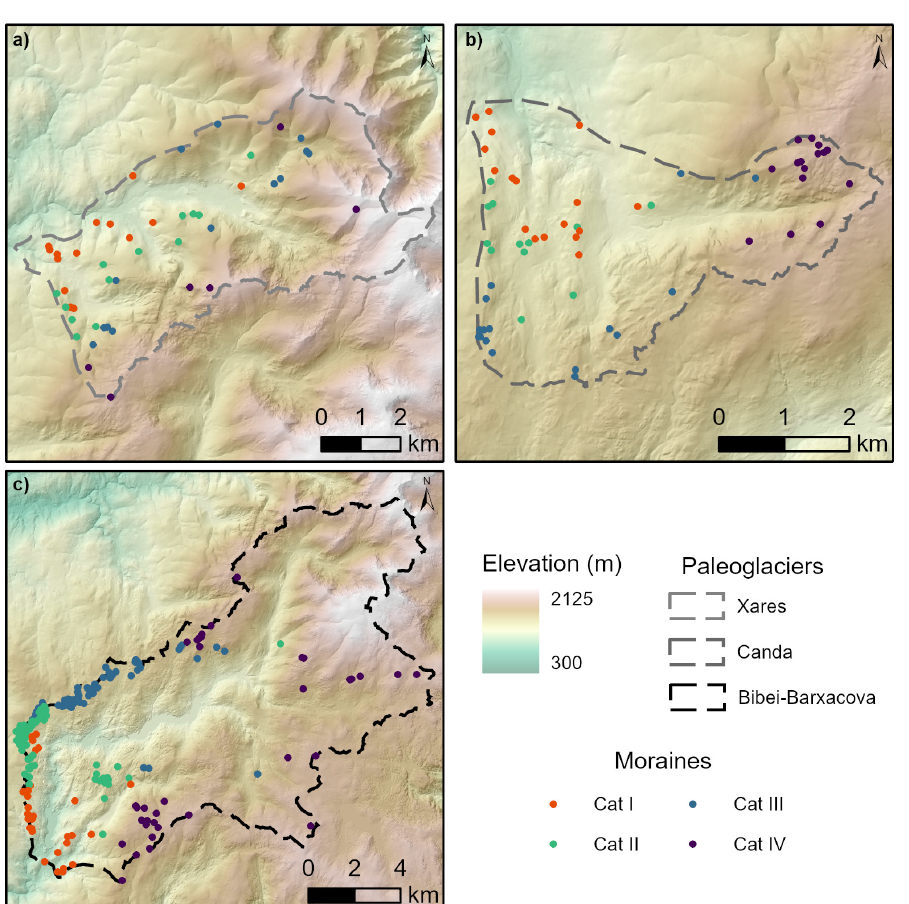
Figure 9. Moraine ridges distribution based on Table 2 categories. ( a ) Xares; ( b ) Canda; and ( c ) Bibei-